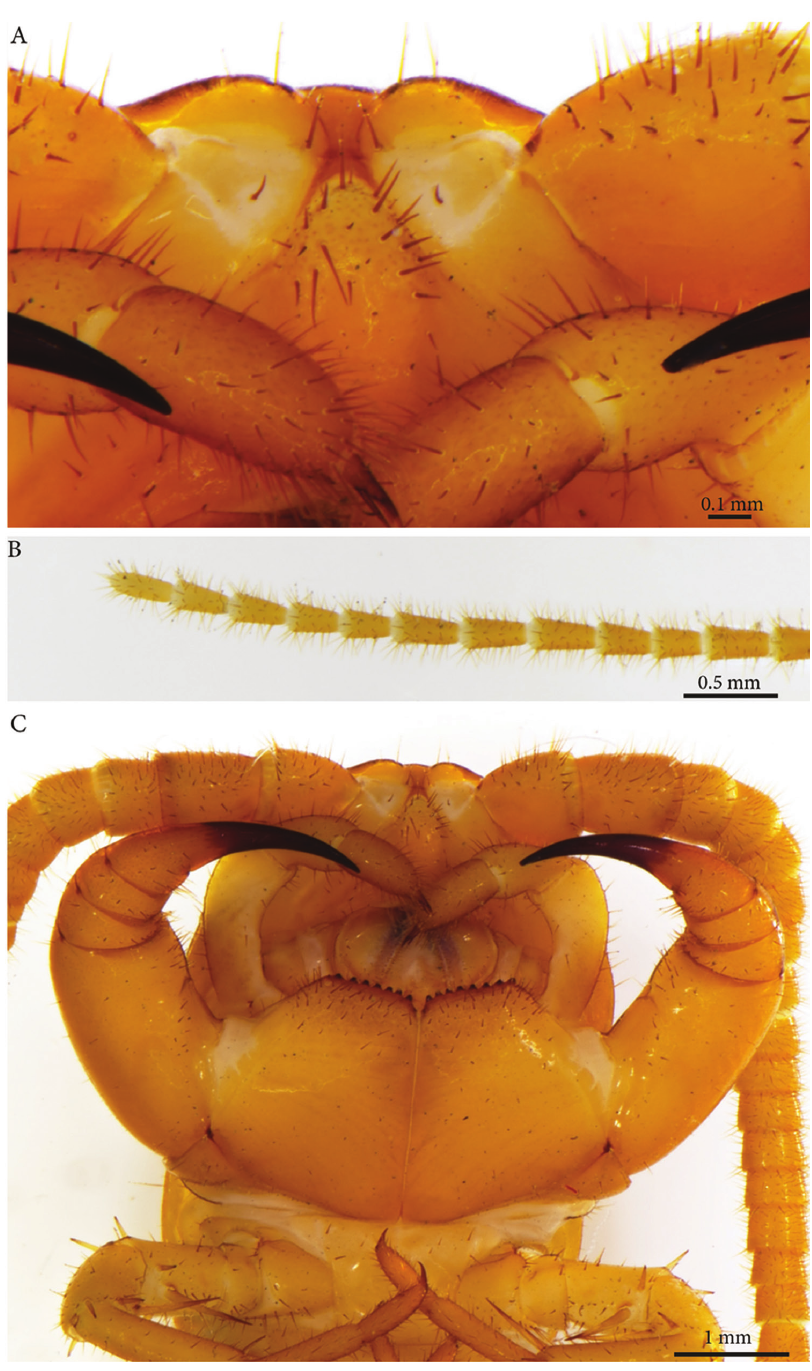
Figure 2. Eupolybothrus liburnicus sp. n., holotype head. A Clypeus, ventral view B Tip of antenna C Forcipules, ventral